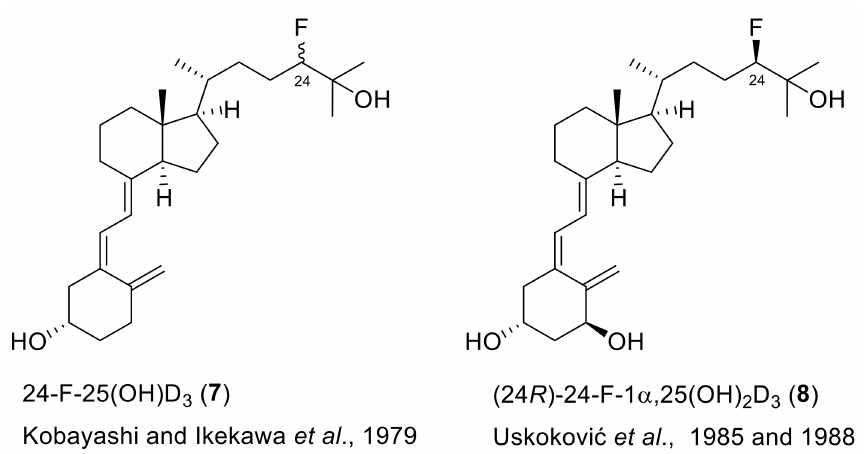
Figure 2. Structures of C24-fluorinated vitamin D 3